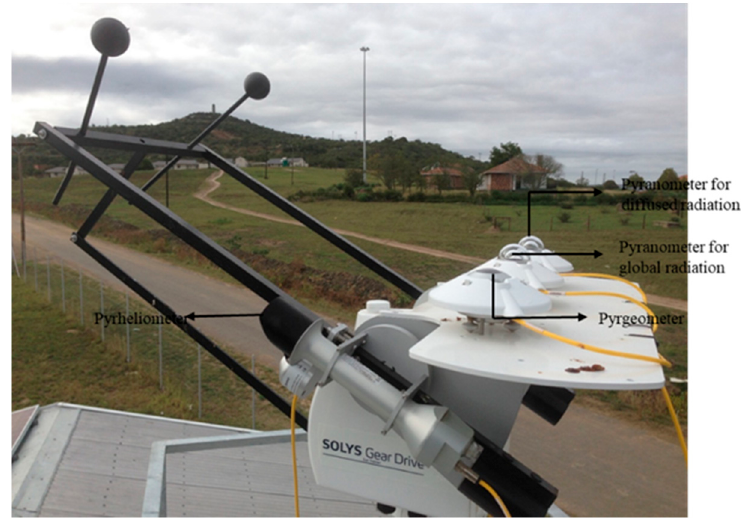
Figure 5. The Sun tracker comprising pyrheliometer, pyranometers and pyrgeometer with the black balls shading the horizontal instruments.